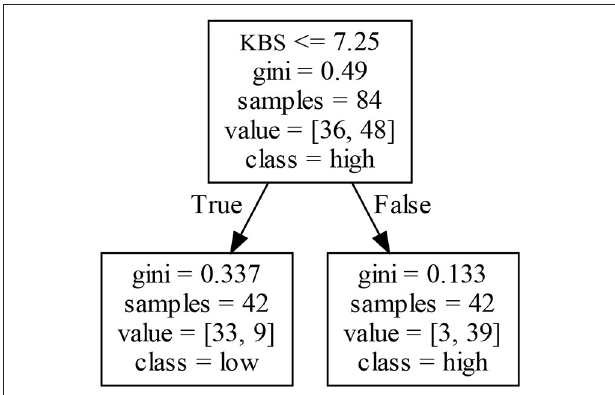
FIGURE 9 | Decision tree for EIP2 in Cluster IV.